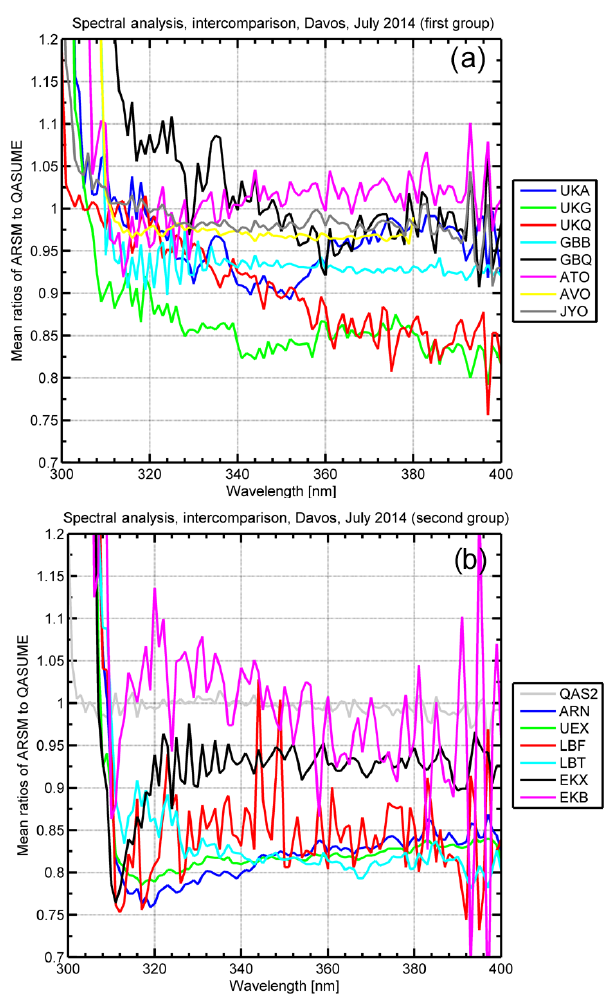
Figure 3. Averaged ratios of the spectral ratio between the QA- SUME reference and the array spectroradiometers participating at the intercomparison. (a) displays instruments from the first group of devices from end users who were in close collaboration with the EMRP project, while (b) indicates ratios of external end users in-